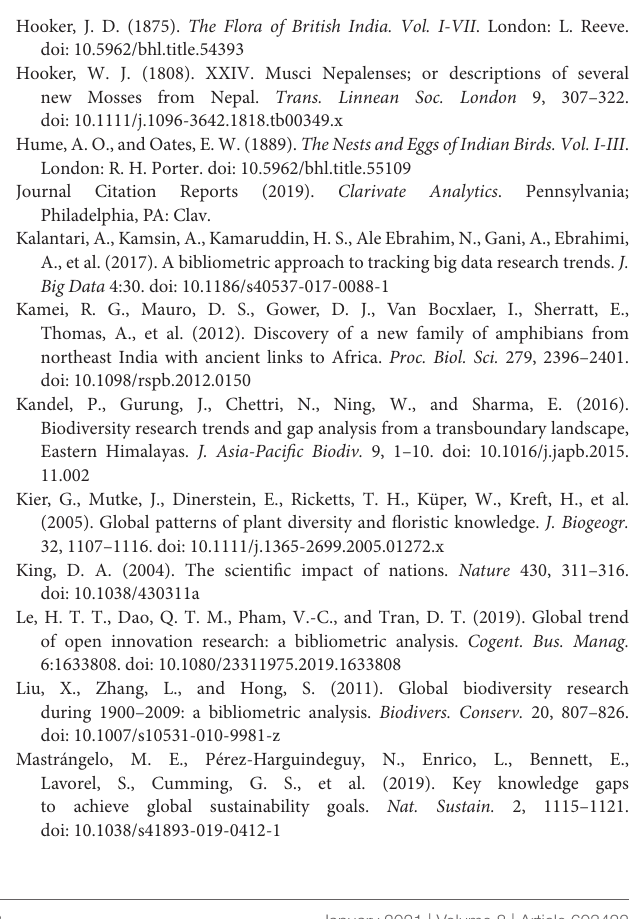
Supplementary Figure 1 | Total number of journal articles published on various research disciplines from 11 Indian Himalayan and northeastern states, Nepal, and Bhutan and their temporal trend during 1950–2018. Supplementary Figure 2 | Total number of journal articles published on various subthemes of ecology from 11 Indian Himalayan and northeastern states, Nepal, and Bhutan and their temporal trend during 1950–2018. Supplementary Figure 3 | Spatial distribution of published journal articles on various animal taxa across the target region. Supplementary Figure 4 | Distribution of articles published on biodiversity from various regions of the Himalaya in various SCI-indexed journals under different impact-factor categories. Supplementary Figure 5 | Top 20 publishing journals on Himalayan biodiversity. Supplementary Figure 6 | Top 10 publishing universities on Himalayan biodiversity. Supplementary Figure 7 | Top 10 publishing agencies of books on Himalayan